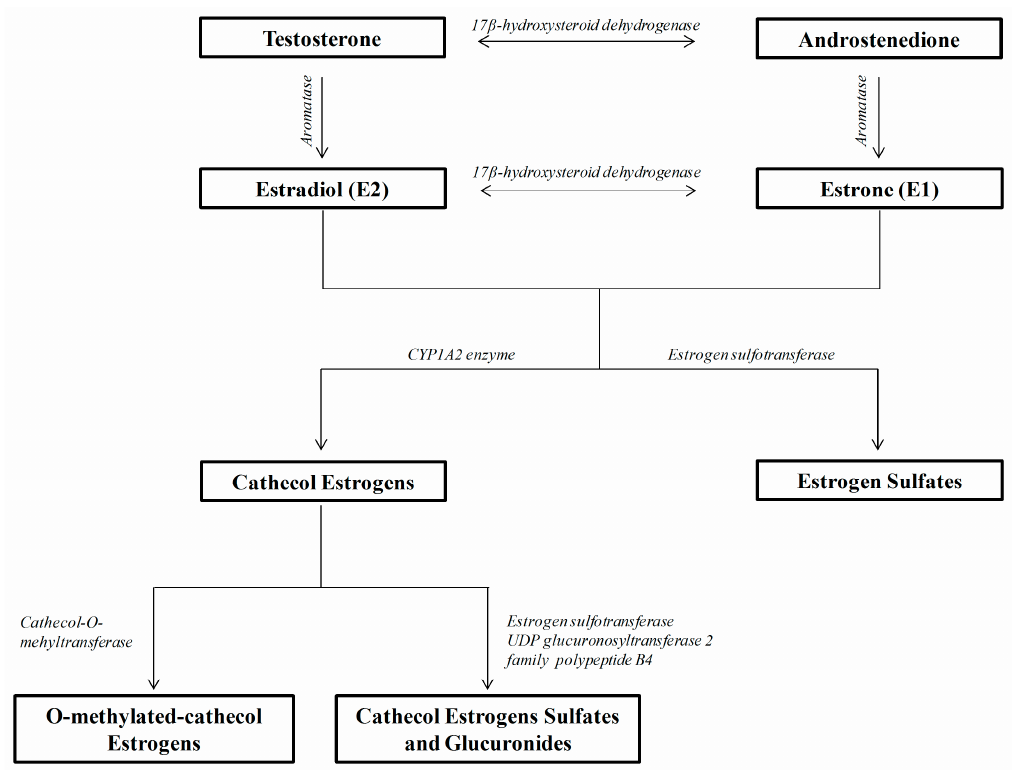
Figure 1. Biosynthesis and metabolism of estrogens.